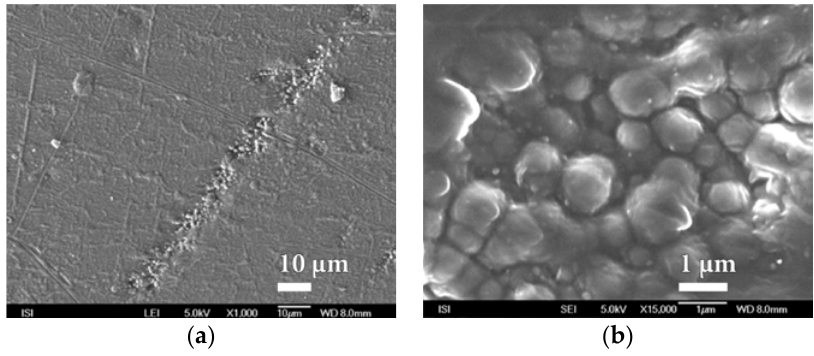
Figure 11. SEM micrographs of melamine nanocoating surface on PEVA SiO x foil prepared by PVD plasma deposition method at magnification of ( a ) 250× and ( b ) 100,000×.